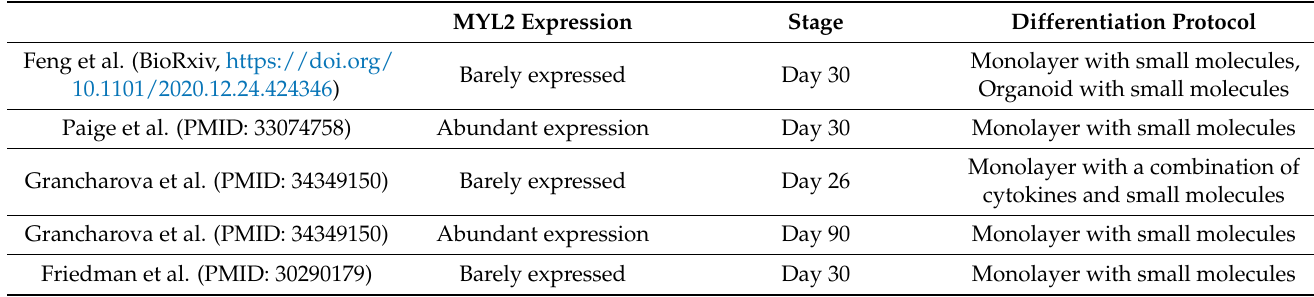
Table 1. The MYL2 expression in WTC parent and derived hiPSC lines in different